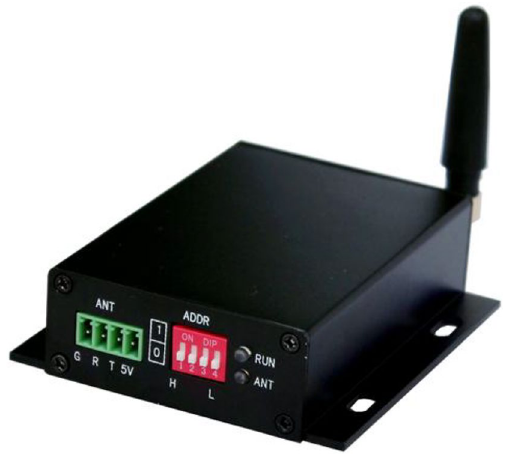
Figure 8. Wireless card reader.